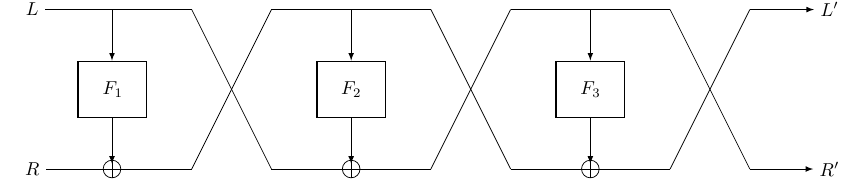
Figure 7: 3-round Feistel E , with E ( L, R ) = ( L 0 , R 0